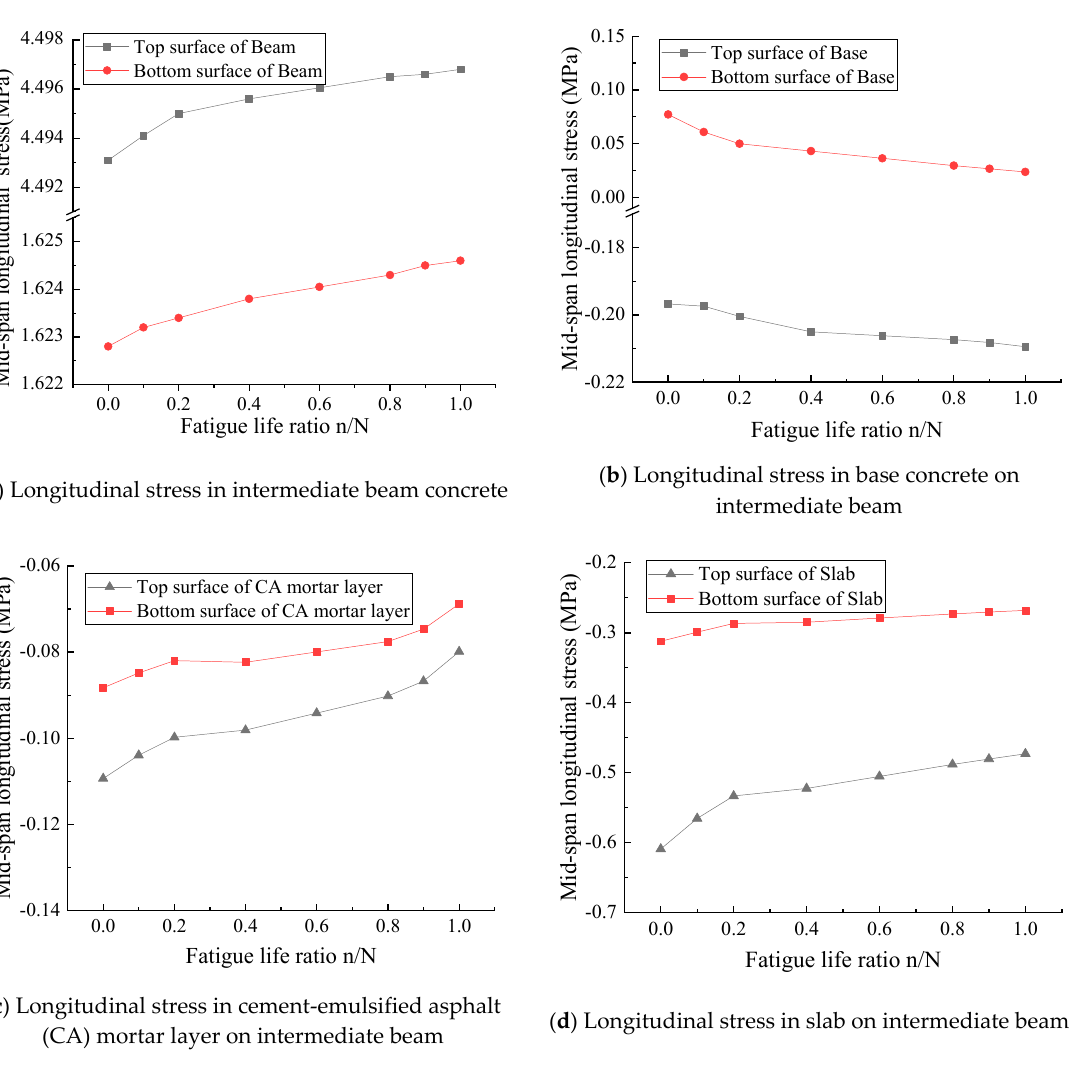
Figure 14. Longitudinal stress on the track–bridge system under fatigue load. Table 6. Stress variation in structural parts.